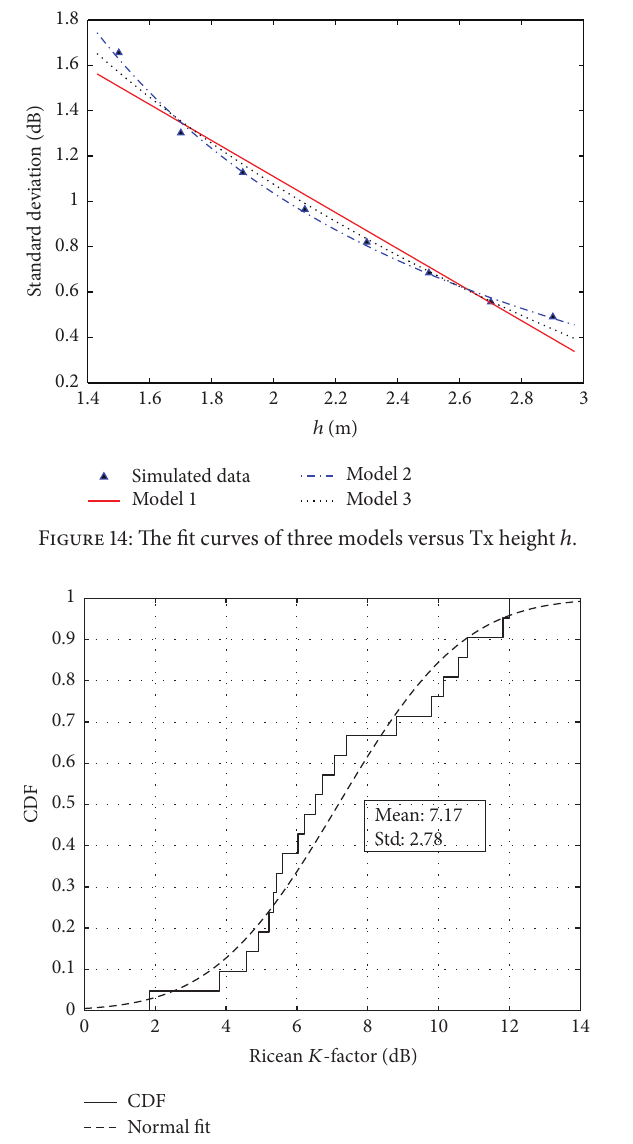
Figure 15: CDF of Ricean 𝐾 -factor in the typical